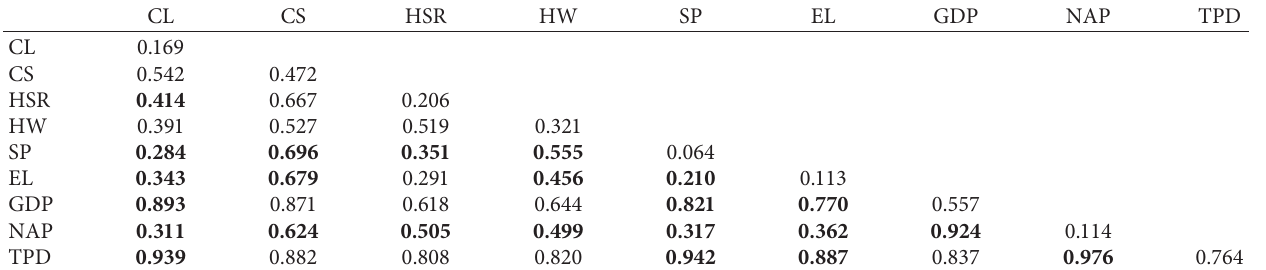
Table 6: Results of interaction detection